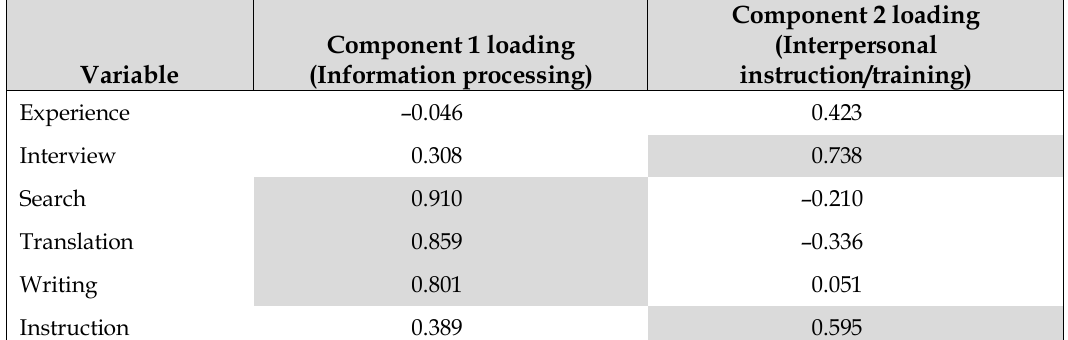
Table 4 Principal components analysis (PCA)